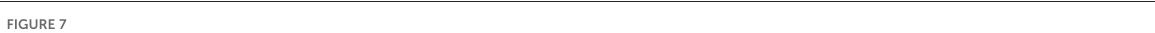
FIGURE7 unknown dorsal and ventral neurons). Box plot displays median and 25–75th % iles; whiskers are 10–90th % iles. Small lettering above bars represents statistical relationships. Although most groups are significantly different from each other, the differences in values are modest in most cases, with the exception of the dorsal and ventral populations. Pairwise comparisons for these groups: Wilcoxon-Mann-Whitney between commissural dorsal and commissural ventral (Figure 2), p = 4 × 10 − 10 ; between unknown dorsal and unknown ventral (Figures 3, 4), p = 0. (F) The average distance of utricular synaptic contacts from the soma, measured along the dendrite, for central neurons separated by their inferred utricular tuning (not including SVN, tangential, and VS neurons). Neurons with inferred contralateral tilt sensitivity (red) received input significantly closer to the soma than neurons with inferred ipsilateral tilt sensitivity (blue, yellow). Small lettering above bars represents statistical relationships. Kruskal-Wallis test among all three groups, p = 0.005. Wilcoxon-Mann-Whitney tests between ipsi-rostral and ipsi-caudal groups, p = 0.35; between ipsi-rostral and contralateral, p = 0.002; between ipsi-caudal and contralateral, p =